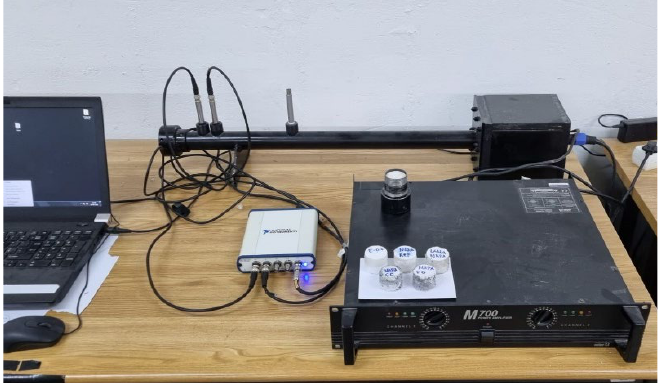
Figure 10. Impedance tube used.